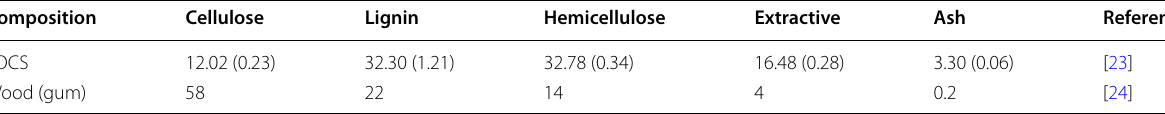
Content (% dry weight particle)